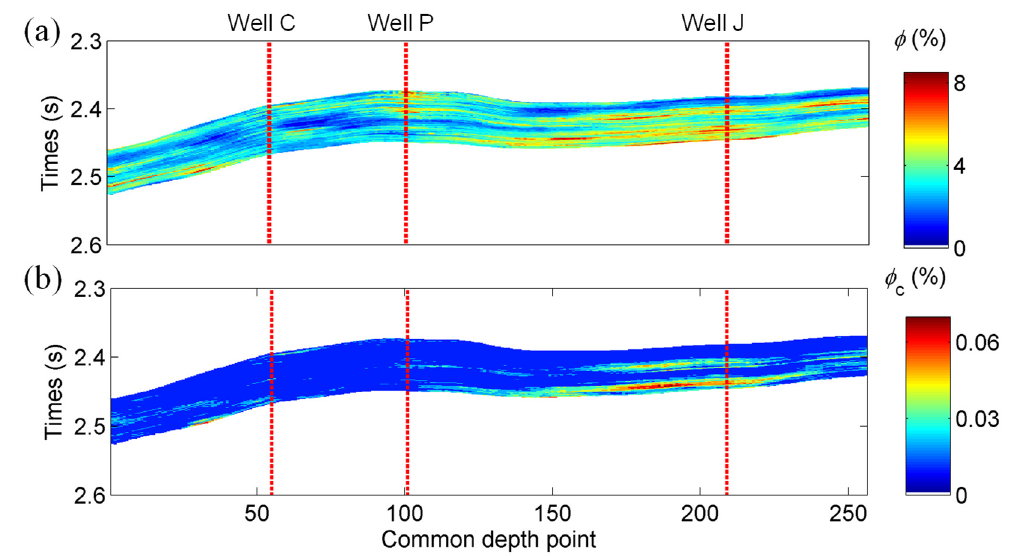
Figure 18. Inversion results of total ( a ) and microcrack ( b ) porosities, corresponding to the data of Figure 17. 3D seismic slices of the work area of ~471 km 2 are produced from the RPTs.